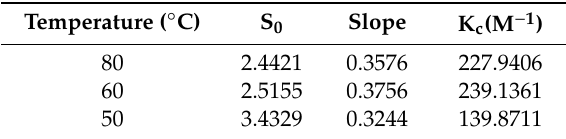
Table 2. Calculated data of phase solubility for binding constant (K c ).